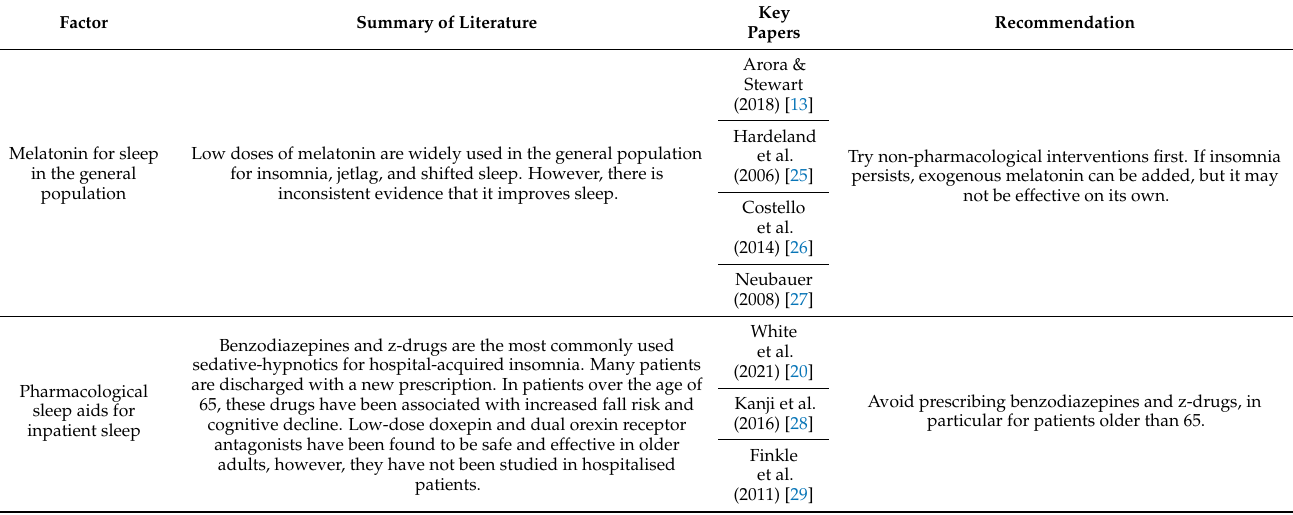
Table 1. Factors to consider when choosing a sleep aid for medical